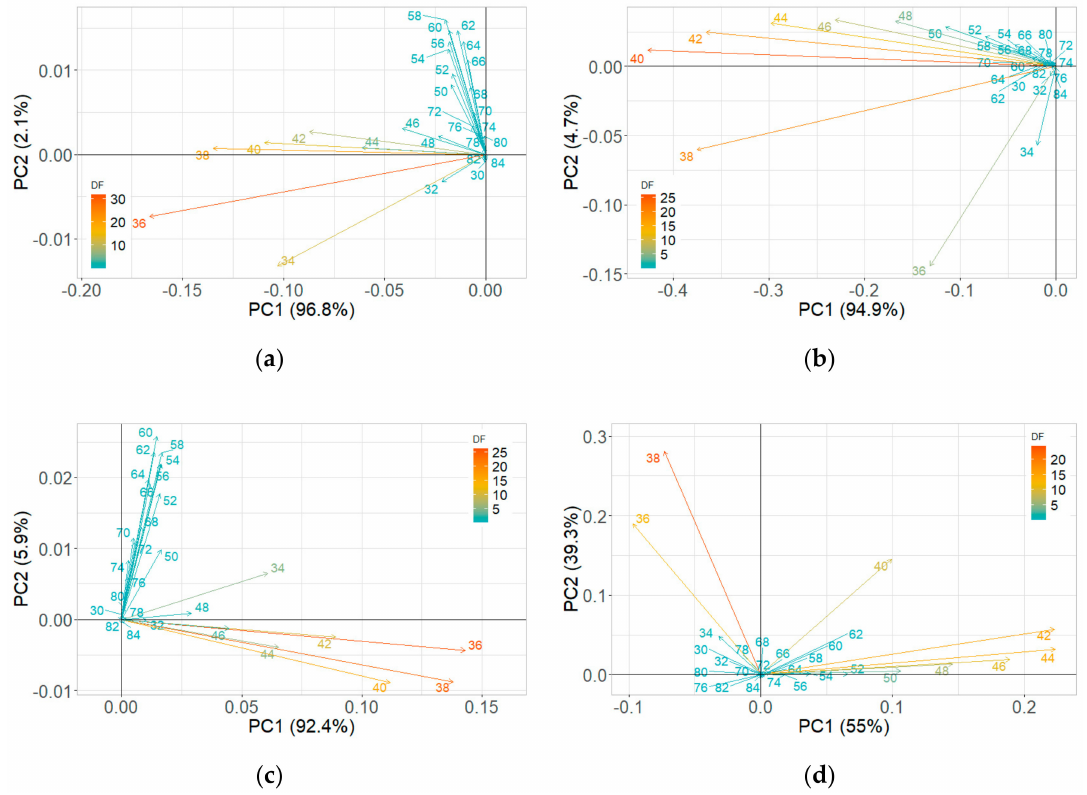
Figure 11. Principal component analysis loading plots for ion current of Ranger Russet tuber samples stored at reduced temperature (4 ◦ C, experiment-3) on ( a ) 0th and ( b ) 31st days after inoculation and Russet Burbank tuber samples stored at reduced temperature (4 ◦ C, experiment-4) on ( c ) 0th and ( d ) 31st days after